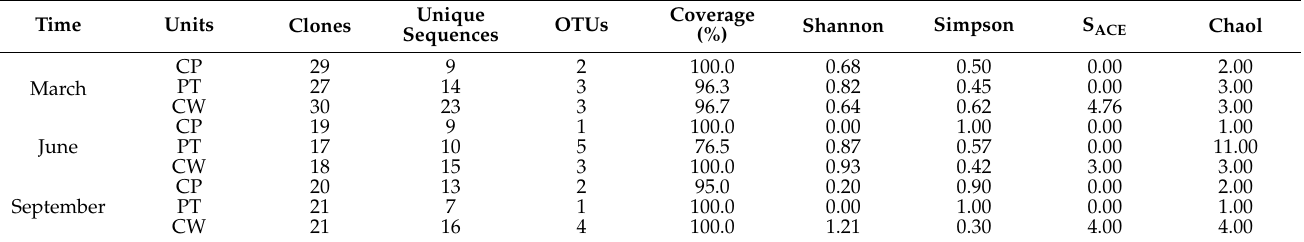
Table 2. Biodiversity and predicted richness of the anammox 16S rRNA genes recovered from the RPAS. Time Units Clones Unique Sequences OTUs Coverage (%) Shannon Simpson S ACE